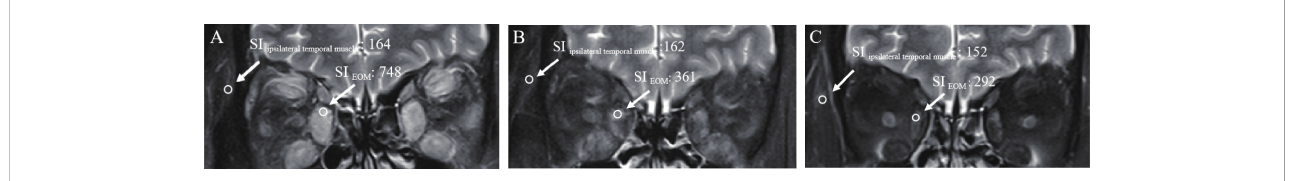
FIGURE 3 Orbital images of a patient with TAO at baseline (A) , 52 weeks (B) , and 224 weeks (C) after rituximab treatment. EOM, extraocular muscle; SI: signal